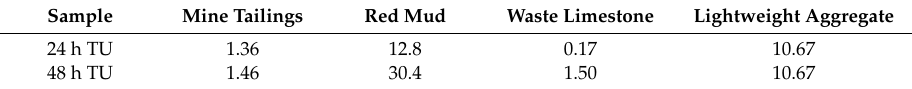
Table 4. Toxic units (TU) of the KSTM-SW leachates determined by using Daphnia magna. Sample Mine Tailings Red Mud Waste Limestone